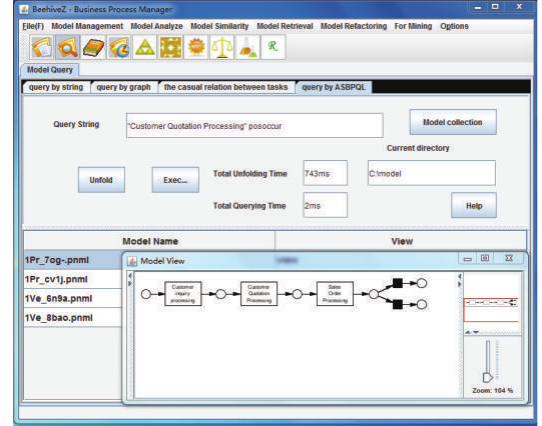
Figure 9: A screenshot of ASBPQL